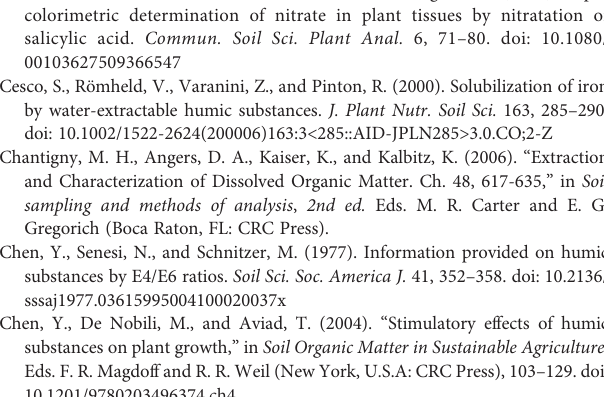
TABLE S1 | List of primers used for real-time RT-PCR